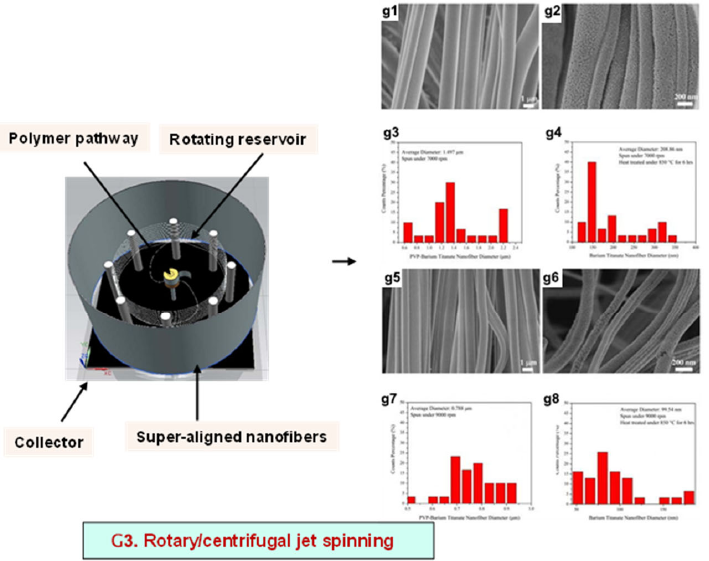
Figure 3. Illustration of electrohydrodynamic techniques and their scanning electron microscope images. ( A3 ) Electrospray method. Reprinted with permission from Ref. [80]. Copyright 2018, Tay ‐ lor & Francis; and its macroporous ZrO2 foams structure formed by the combination of ( a1 )